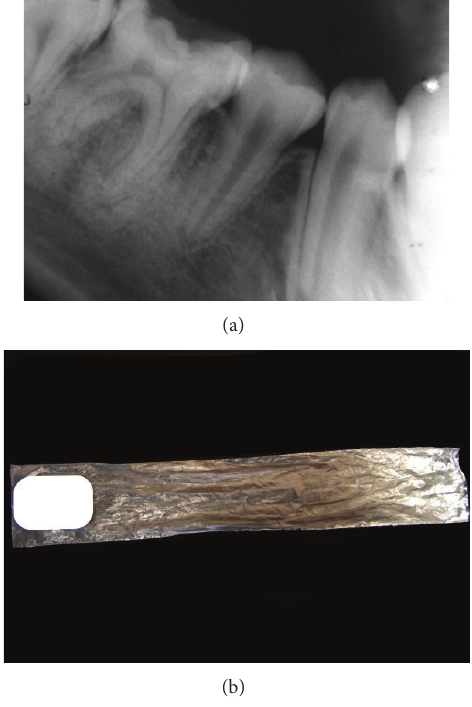
Figure 4: Periapical radiographic examination showing the pres- ence of the first permanent molar with extensive caries and peri- odontal ligament thickening (a). An intraoral radiographic film enclosed in a plastic bag (4 × 23 cm) (b).